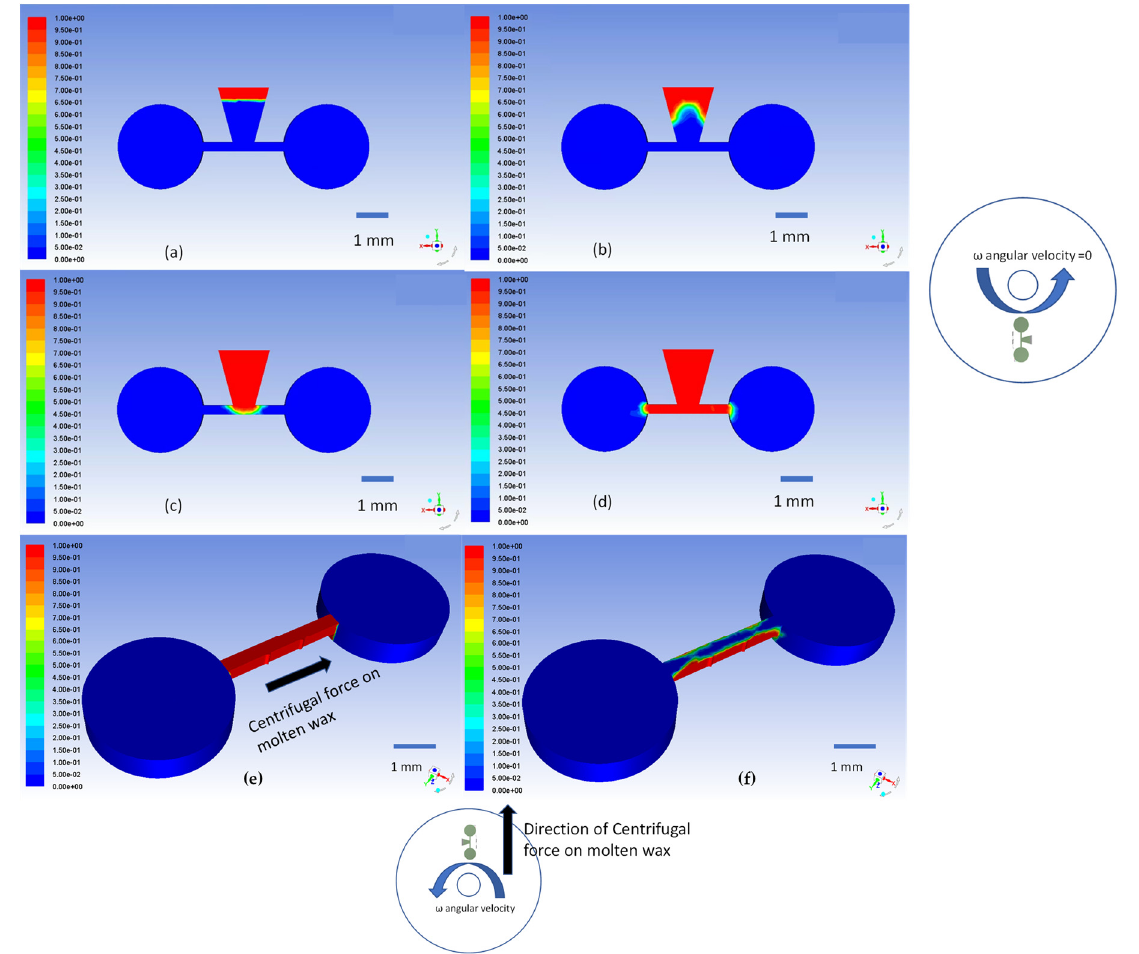
Figure 6. ( a ) The simplified 3D geometry used in ANSYS simulation of two-phase laminar flow represents the molten wax region in red (V.F wax = 1) and the air phase in blue (V.F wax = 0); ( b ) the air/wax interface is the concave meniscus moving towards the valving channel; ( c ) moving molten wax is entering the valving channel; ( d ) the molten wax fills the channel and blocks the connecting channel between the inward and the outward chambers. The right illustration depicts the location of the valve and the spin direction of the CD. ( e ) ANSYS simulation of the normally closed to open valve with the molten ferrowax blocking the connecting channel. A centrifugal force for spinning of the CD at 6500 rpm is applied. This is also shown in the inset of the CD at the bottom. ( f ) The simulation results clearly show that the centrifugal force pushes the molten wax towards the outward channel and opens the connecting fluid channel. The color indicates the volume fraction of molten wax (color: red, VF wax = 1.0) vs. air (color: blue, VF wax = 0.0). Present simulation results refer to wax valve without the adjoining fluid